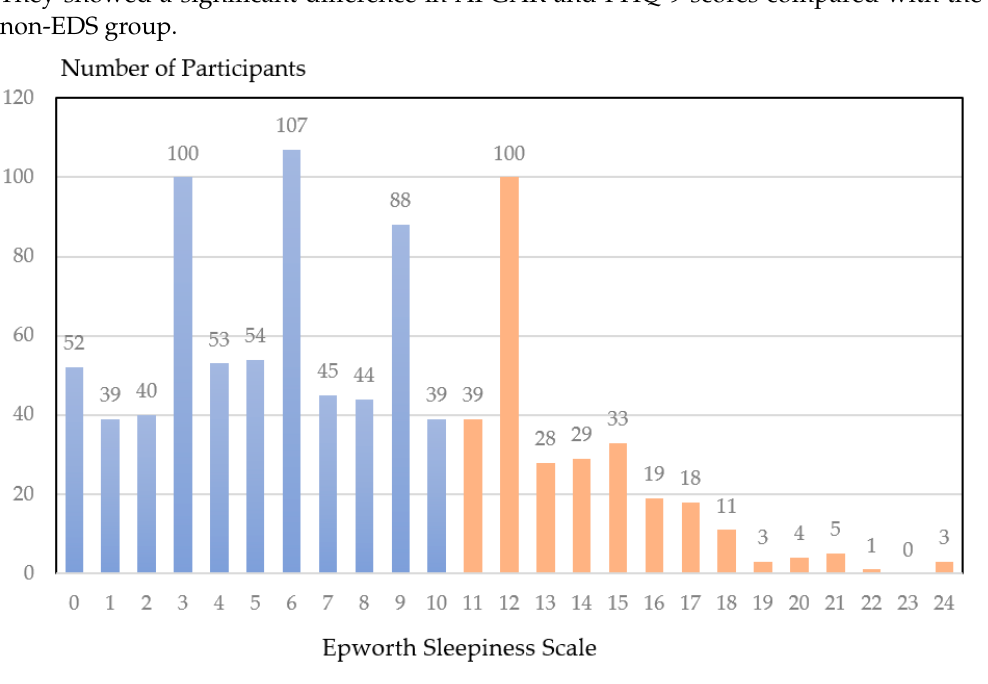
Table 2. Factors associated with EDS.